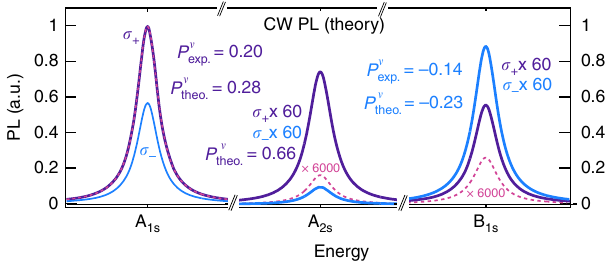
Fig. 4 CW photoluminescence valley polarization for A and B excitons. polarized light at A 1s , A 2s , and B 1s states. The difference between the σ + and corresponding states. The thin dashed lines show the PL without the